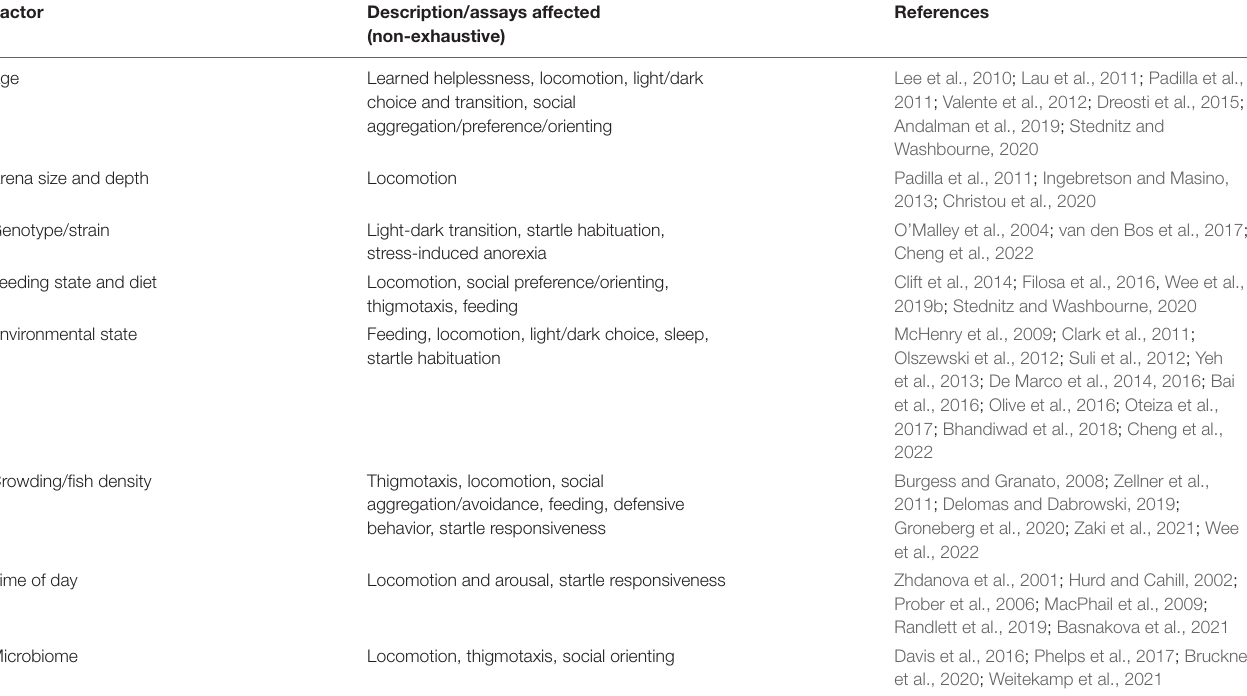
TABLE 3 | Summary of factors influencing behavioral assay